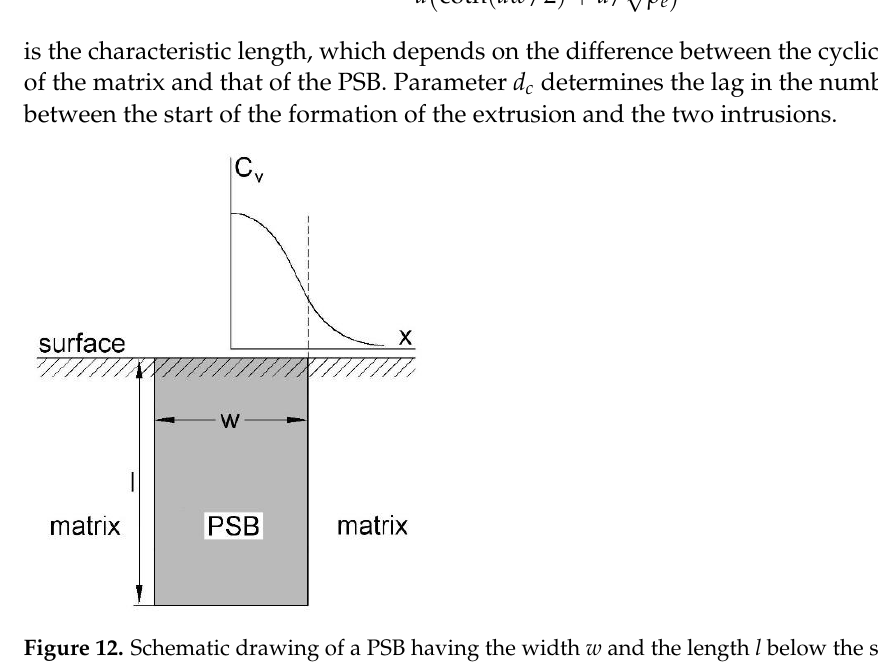
Figure 11. Schematics of vacancy formation and migration in PSB ( a ) and surface relief formation at egressing PSB ( b ).